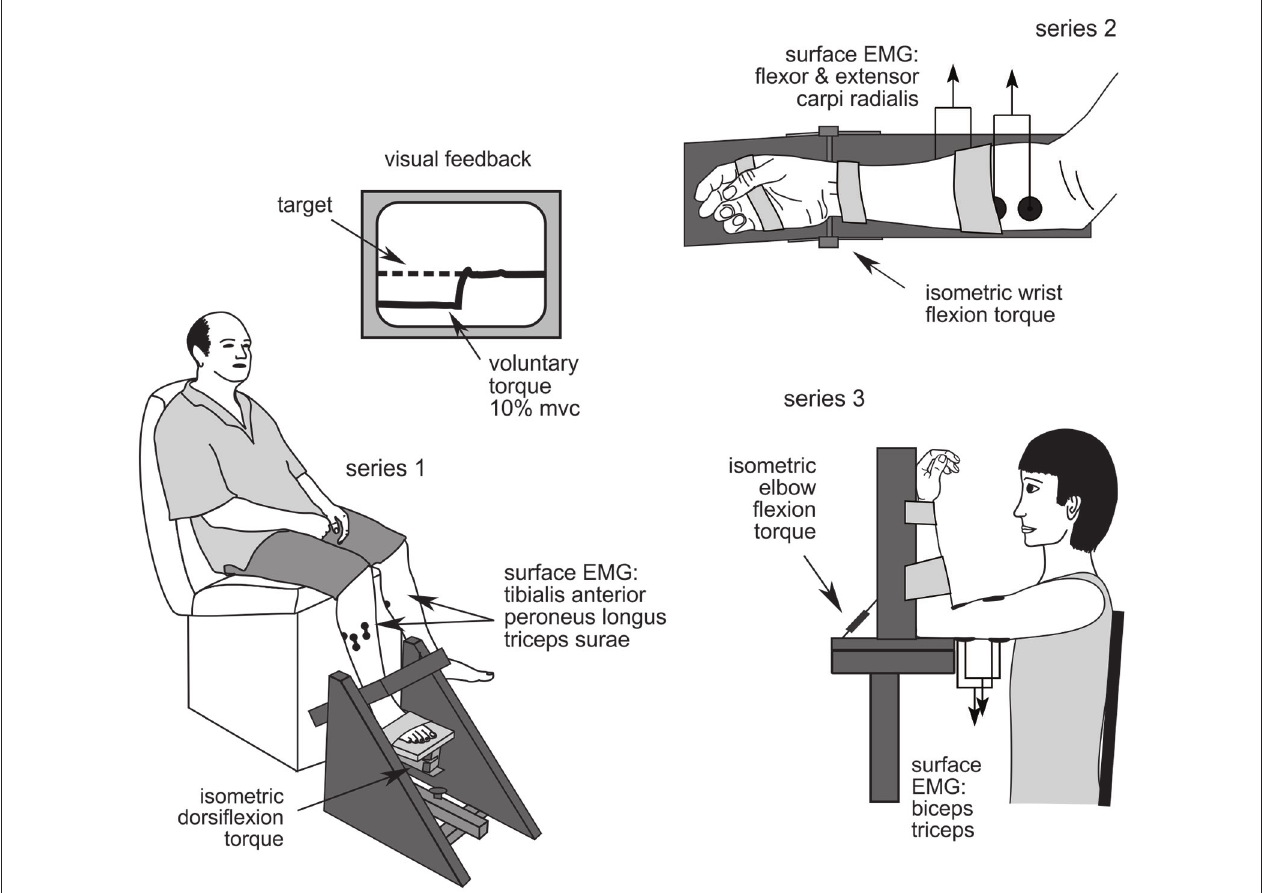
FIGURE 1 | Experimental set up . Series 1: ankle dorsiflexion; series 2: wrist flexion; and series 3: elbow flexion.